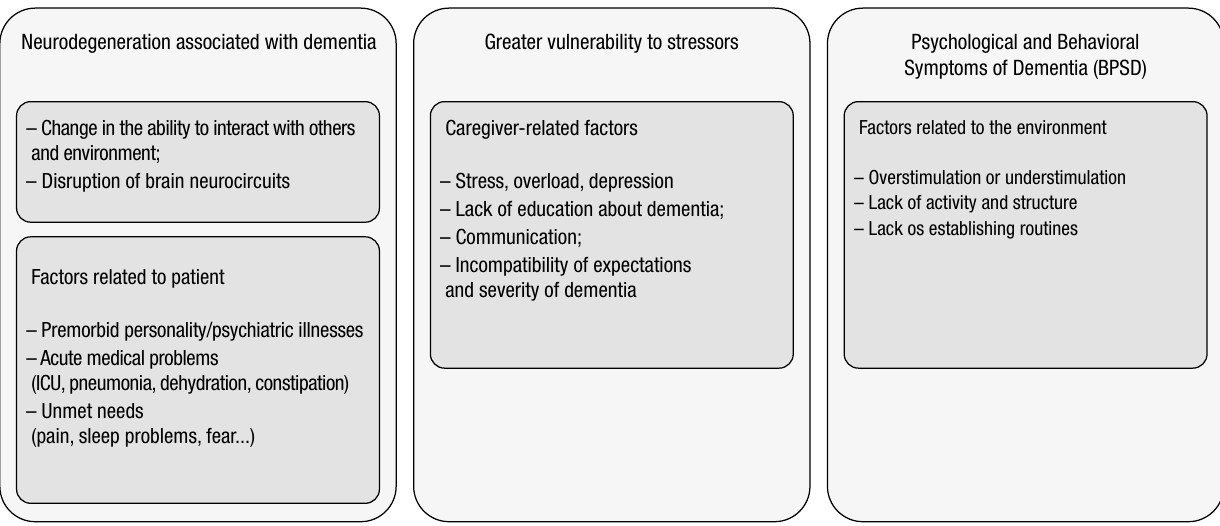
Figure 1. Depiction of a conceptual model for different interactions resulting in BPSD. Adapted from Kales (2015) 58 .